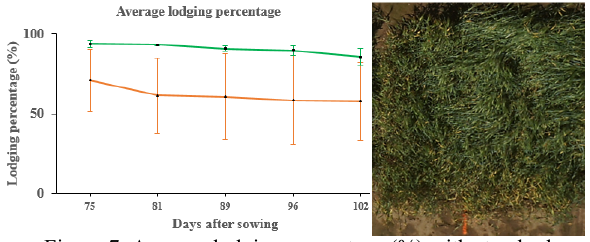
Figure 7. Average lodging percentage (%) with standard deviation for both sowing densities (high = green, low = orange) and genotype 2 (left). RGB image to illustrate the lodging pattern for genotype 2 (right).